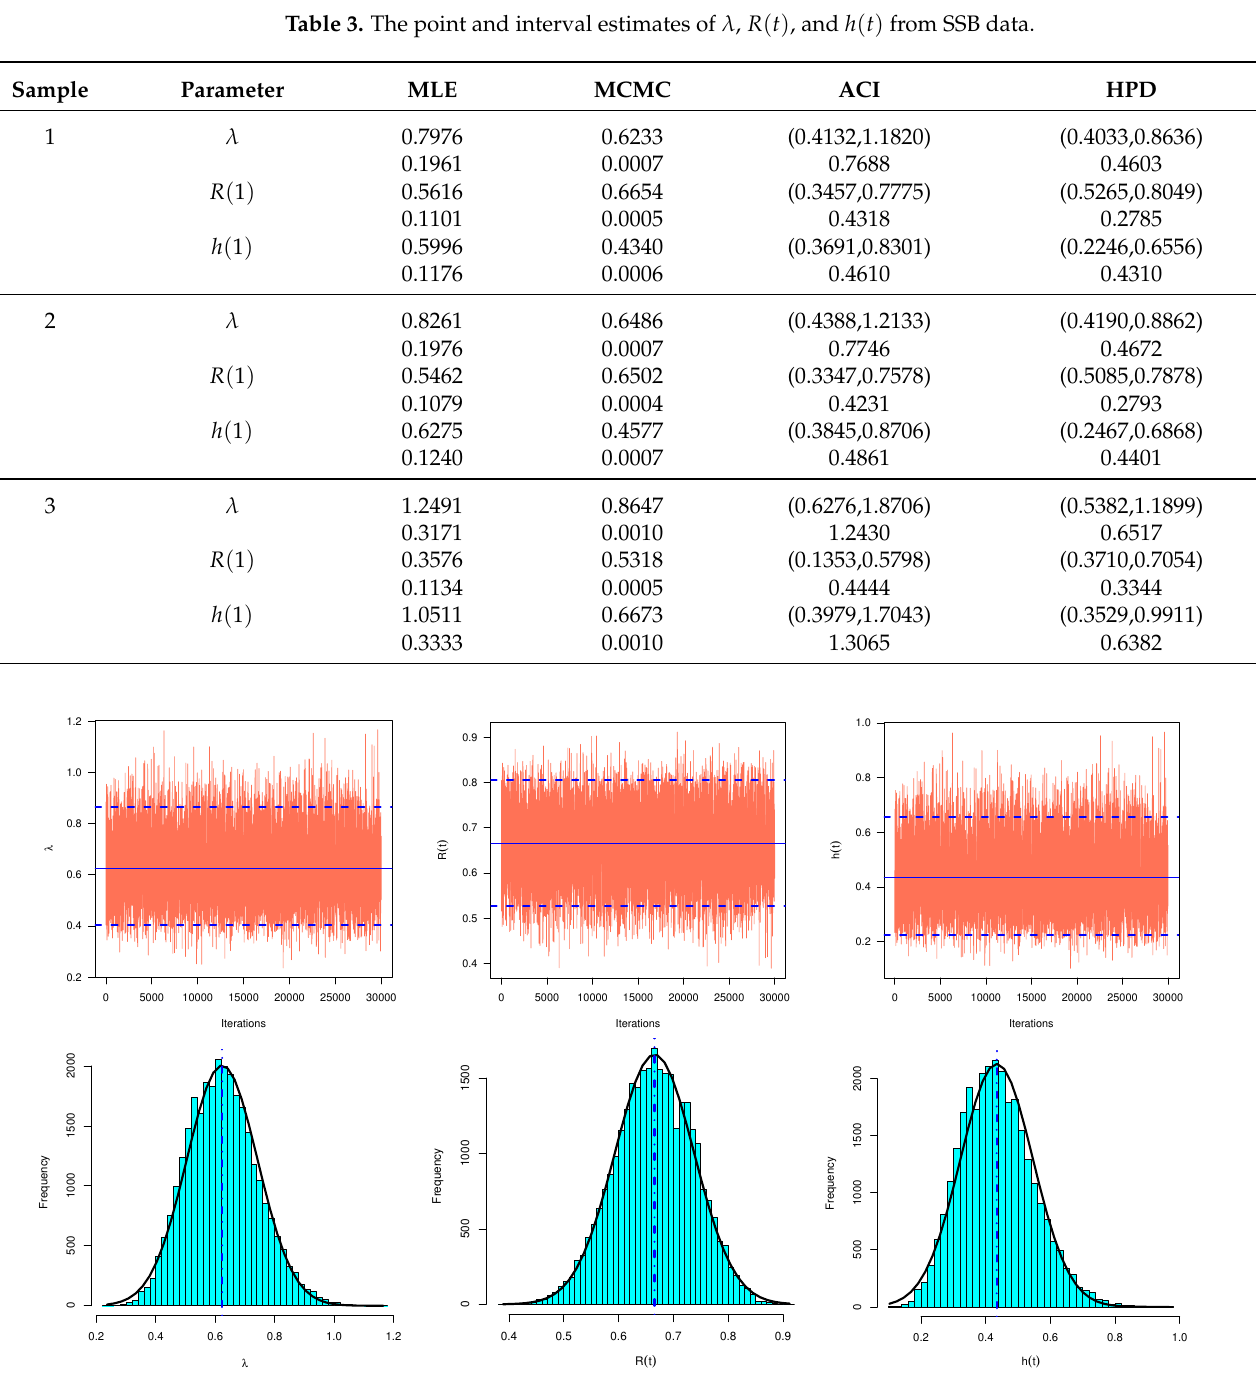
Figure 10. Trace plots ( top-panel ) and Histograms ( bottom-panel ) of λ , R ( t ) , and h ( t ) from SSB